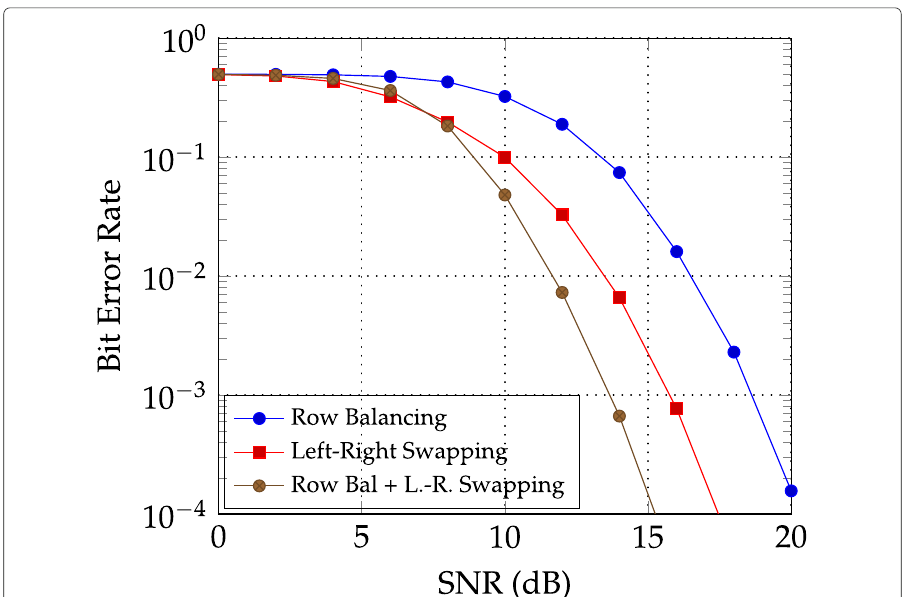
of channel estimation errors in a MIMO wideband system using LU-based spatial multi- plexing. The exact channel polynomial matrix is still denoted by H ( z ) and its estimation (cid:3) H ( z ) = H ( z ) + (cid:11) H ( z ) . The power of the estimation error (cid:11) H ( z ) is will be denoted by given by the square of the L 2 matrix norm: